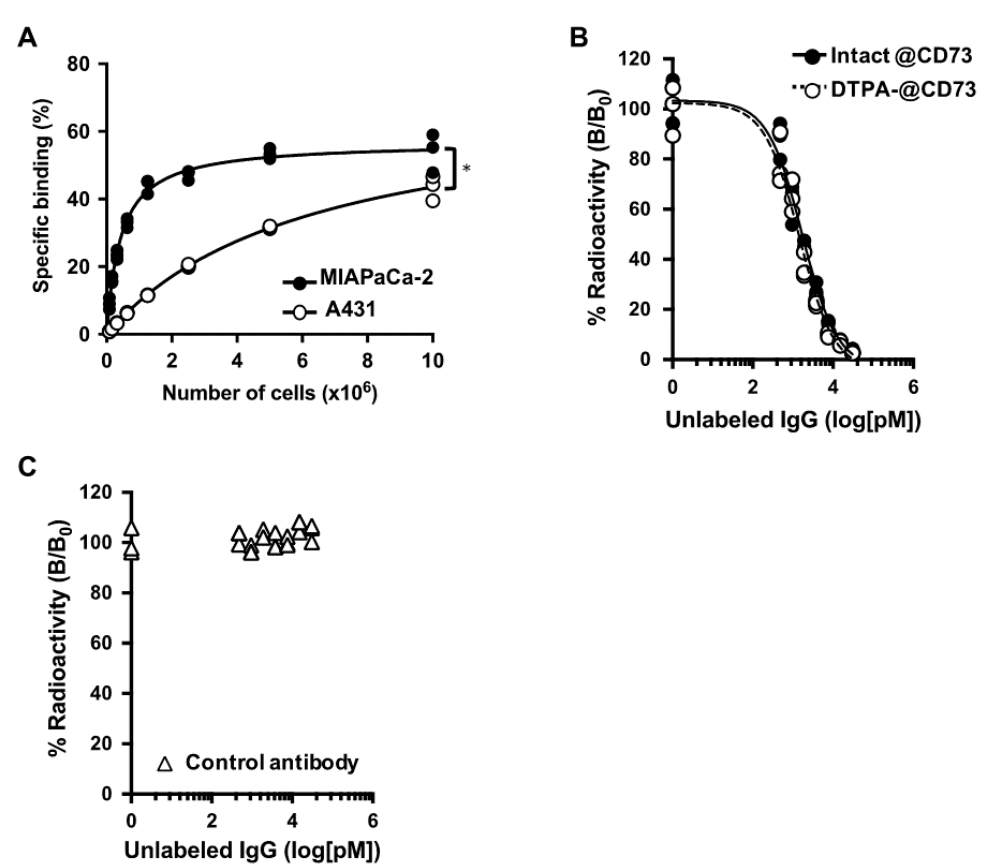
Figure 2. ( A ) Cell binding assay of 111 In-labeled anti-CD73 antibody 067-213 with MIAPaCa-2 (CD73 high, black circles) and A431 (CD73 low, white circles) cells. * p < 0.05. ( B ) Competitive inhibition assay of 111 In-labeled anti-CD73 antibody to MIAPaCa-2 cells with intact anti-CD73 antibody (black circles) and CHX-A”-DTPA-conjugated CD73 antibody (white circles) as a competitor. ( C ) Competitive inhibition assay of 111 In-labeled anti-CD73 antibody to MIAPaCa-2 cells with control antibody as the competitor.